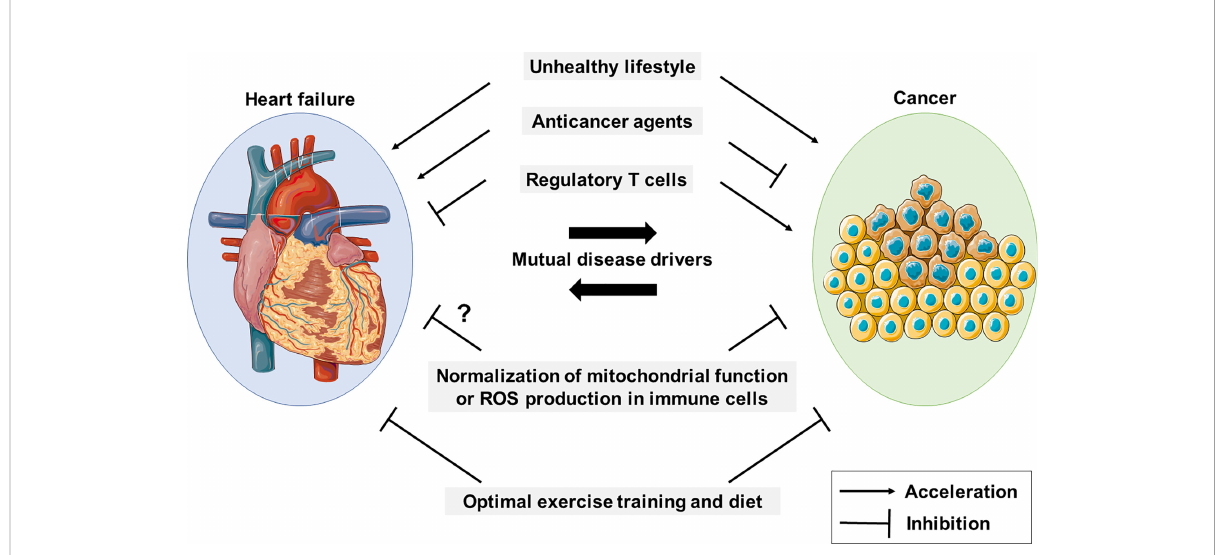
FIGURE 1 Cancer and HF mutually promote each other. An unhealthy lifestyle contributes to the development of cancer and CHF, and they are mutual disease drivers. Anticancer drugs and regulatory T cells appear to have con fl icting roles in cancer and HF. Mitochondrial function and reactive oxygen species (ROS) production in immune cells are potential therapeutic targets in both